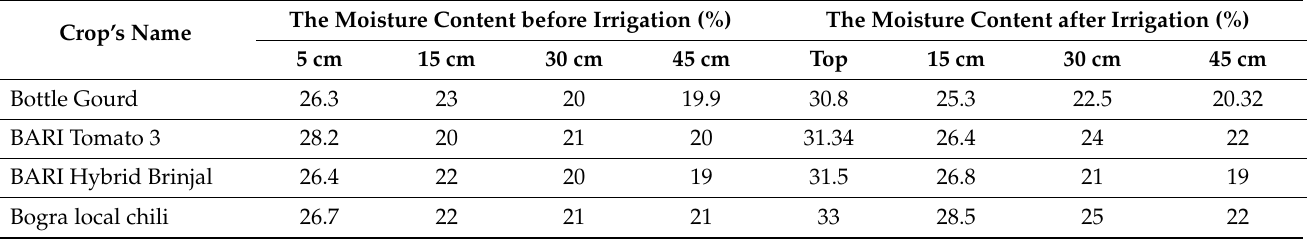
Table 3. The average moisture content of soil at different depths in the container during, before and after irrigation (from the top of the container).